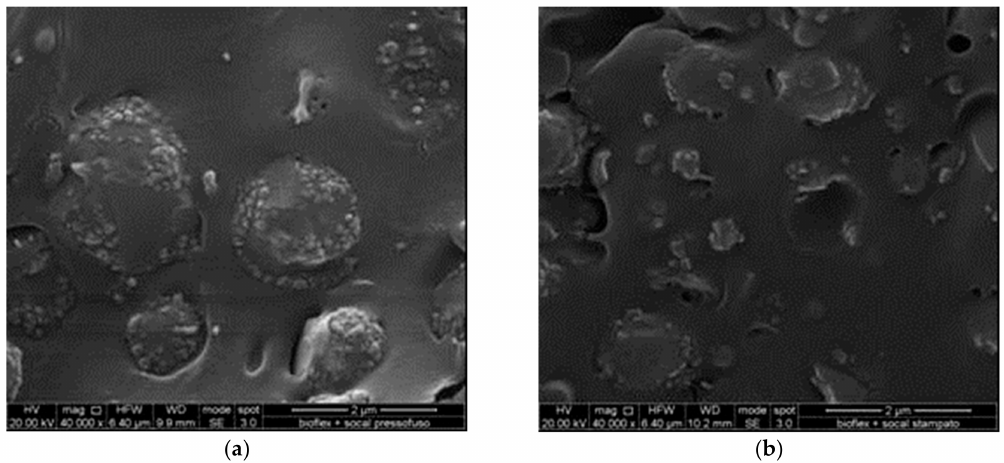
Figure 7. ( a ) SEM fracture surfaces of B+S-CM sample; ( b ) SEM fracture surfaces of B+S-IM